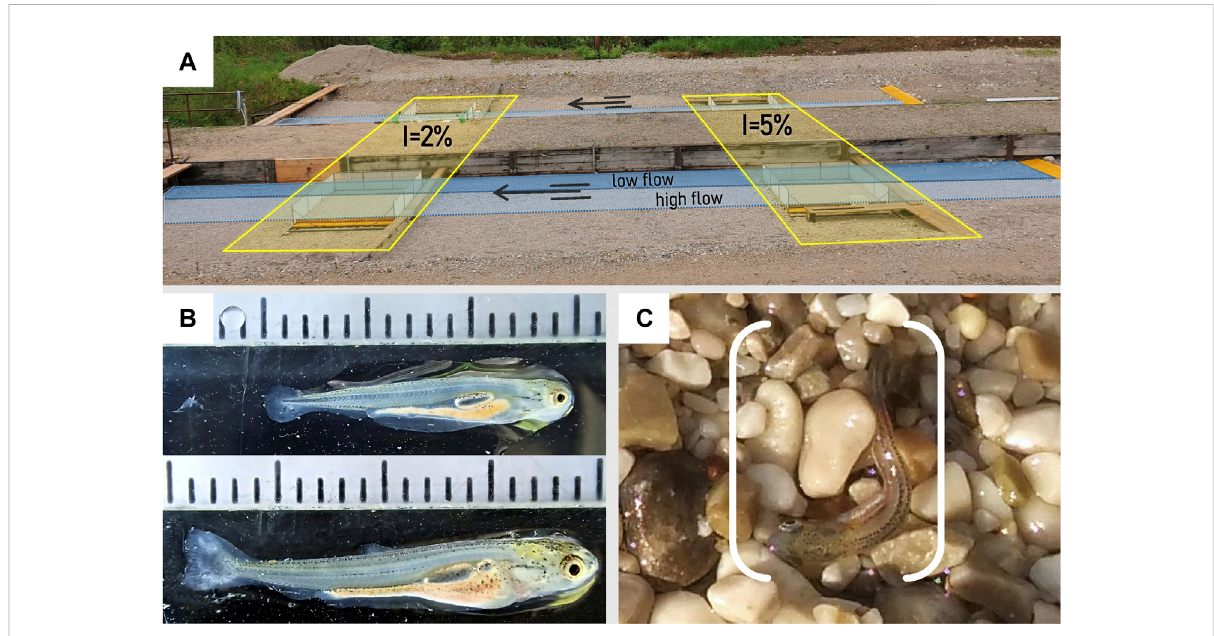
FIGURE 1 (A) Sideview ofbothexperimentalchannels with thefourembeddedmesocosms:twoeachwithabankslope Iof2%and5%,respectively;blue shadings indicatethewetted areaatlow fl owsand high fl owsduringtheexperiments (B) Larvaestages usedintheexperiments;top:stageIII-IVwith TL = 15.0 mm, bottom: stage V with TL = 19.2 mm. For details, see Pe ň áz (1974); (C) Larval nase ( Chondrostoma nasus L.) stranded by rapid down- ramping during the experiments.